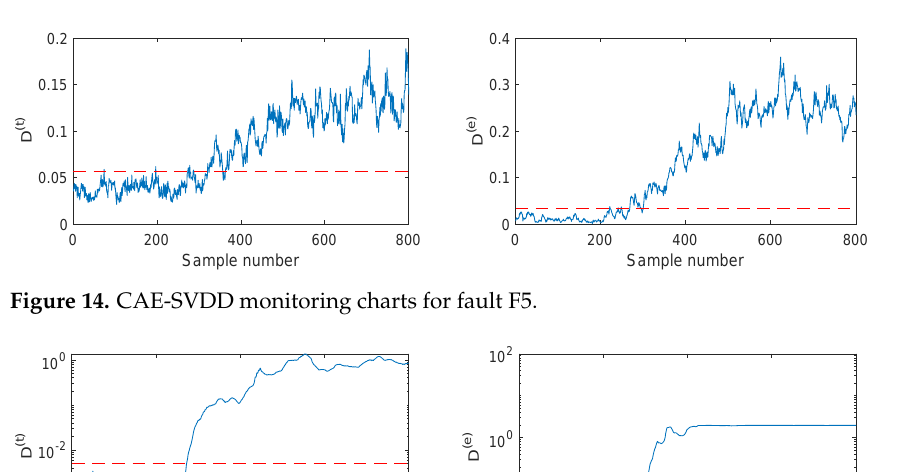
Figure 13. AE-SVDD monitoring charts for fault F5.